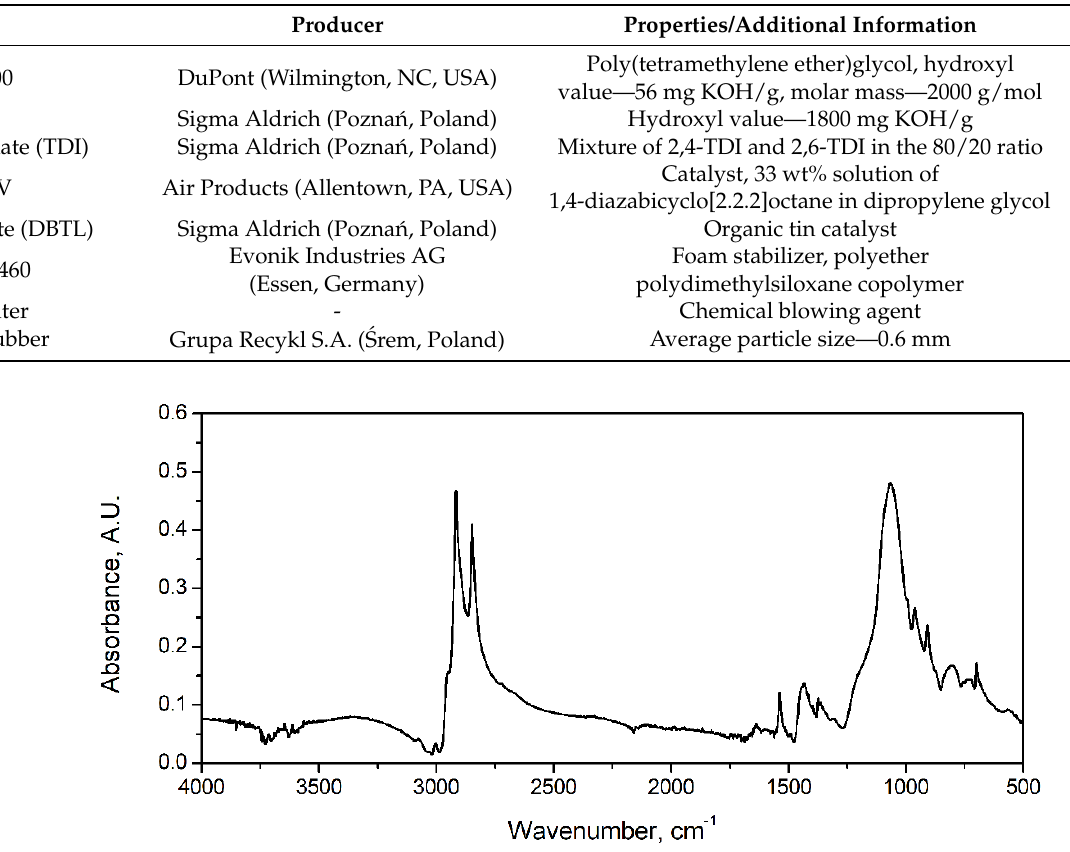
Figure 1. FTIR spectra of GTR applied as filler for investigated PU -based composites.